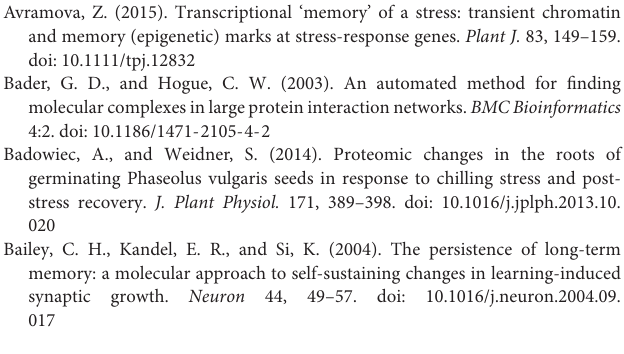
Supplementary Table 2 | Stress & memory acclimation genes in plants and their homologs in rice. Supplementary Table 3 | Classification of 39 prion-like candidates into 10 different functional categories. Supplementary Table 4 | Gene ontology (GO) enrichment analysis for all the organisms under study. Supplementary Table 5 | PrLP candidates predicted in the rice prionome with their sub-cellular localizations. Supplementary Table 6 | The 66 rice PrLPs with diurnal expression profiles. Supplementary Table 7 | The rice prionome significant co-expression data sets. Supplementary Table 8 | Rice prionome master gene regulatory